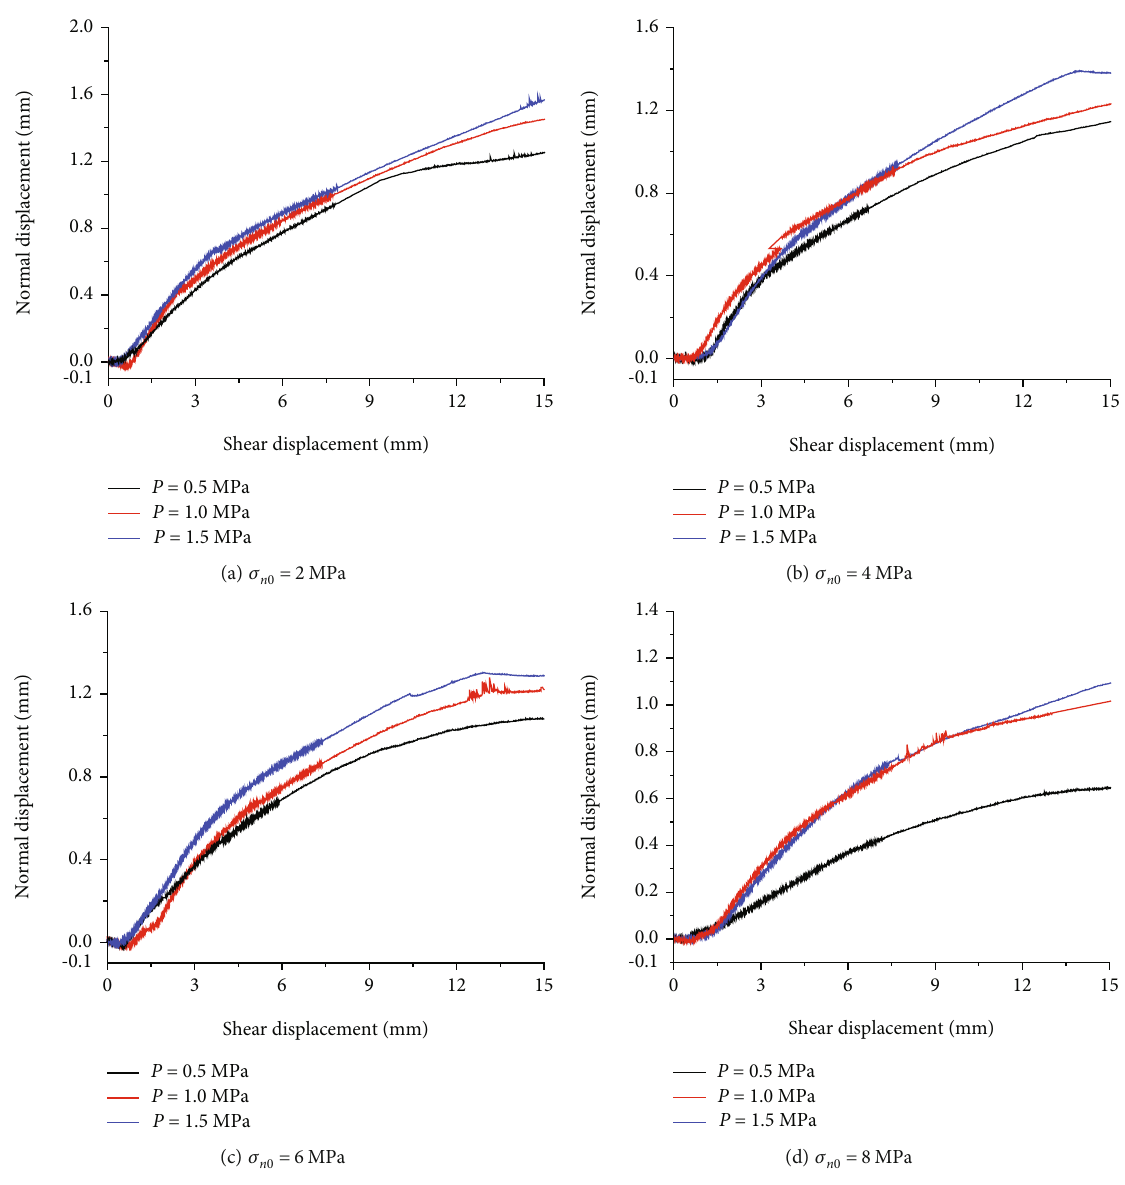
Figure 14: Curves of normal displacement with shear